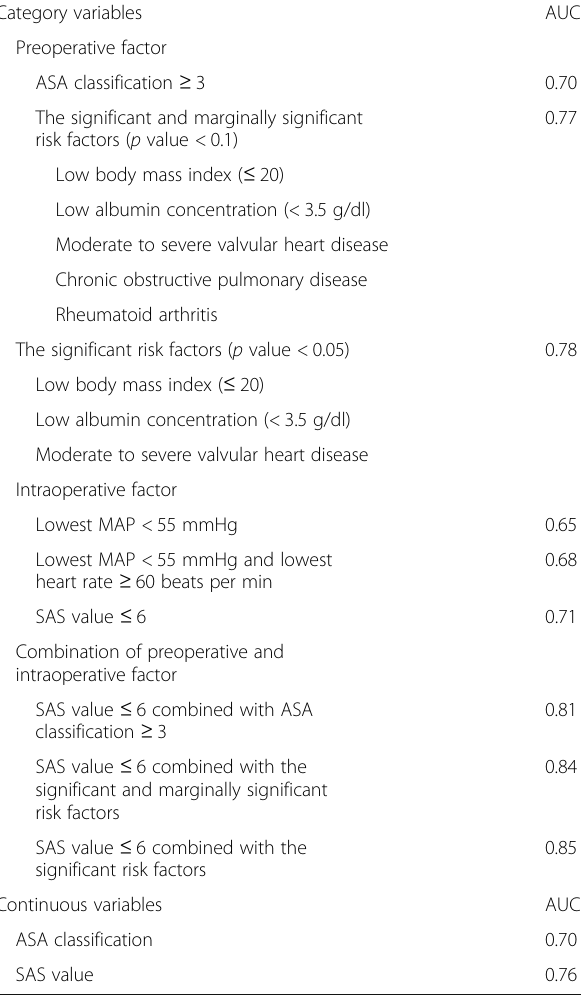
Table 6 Area under the receiver operating characteristic curve to predict the 90-day mortality for each